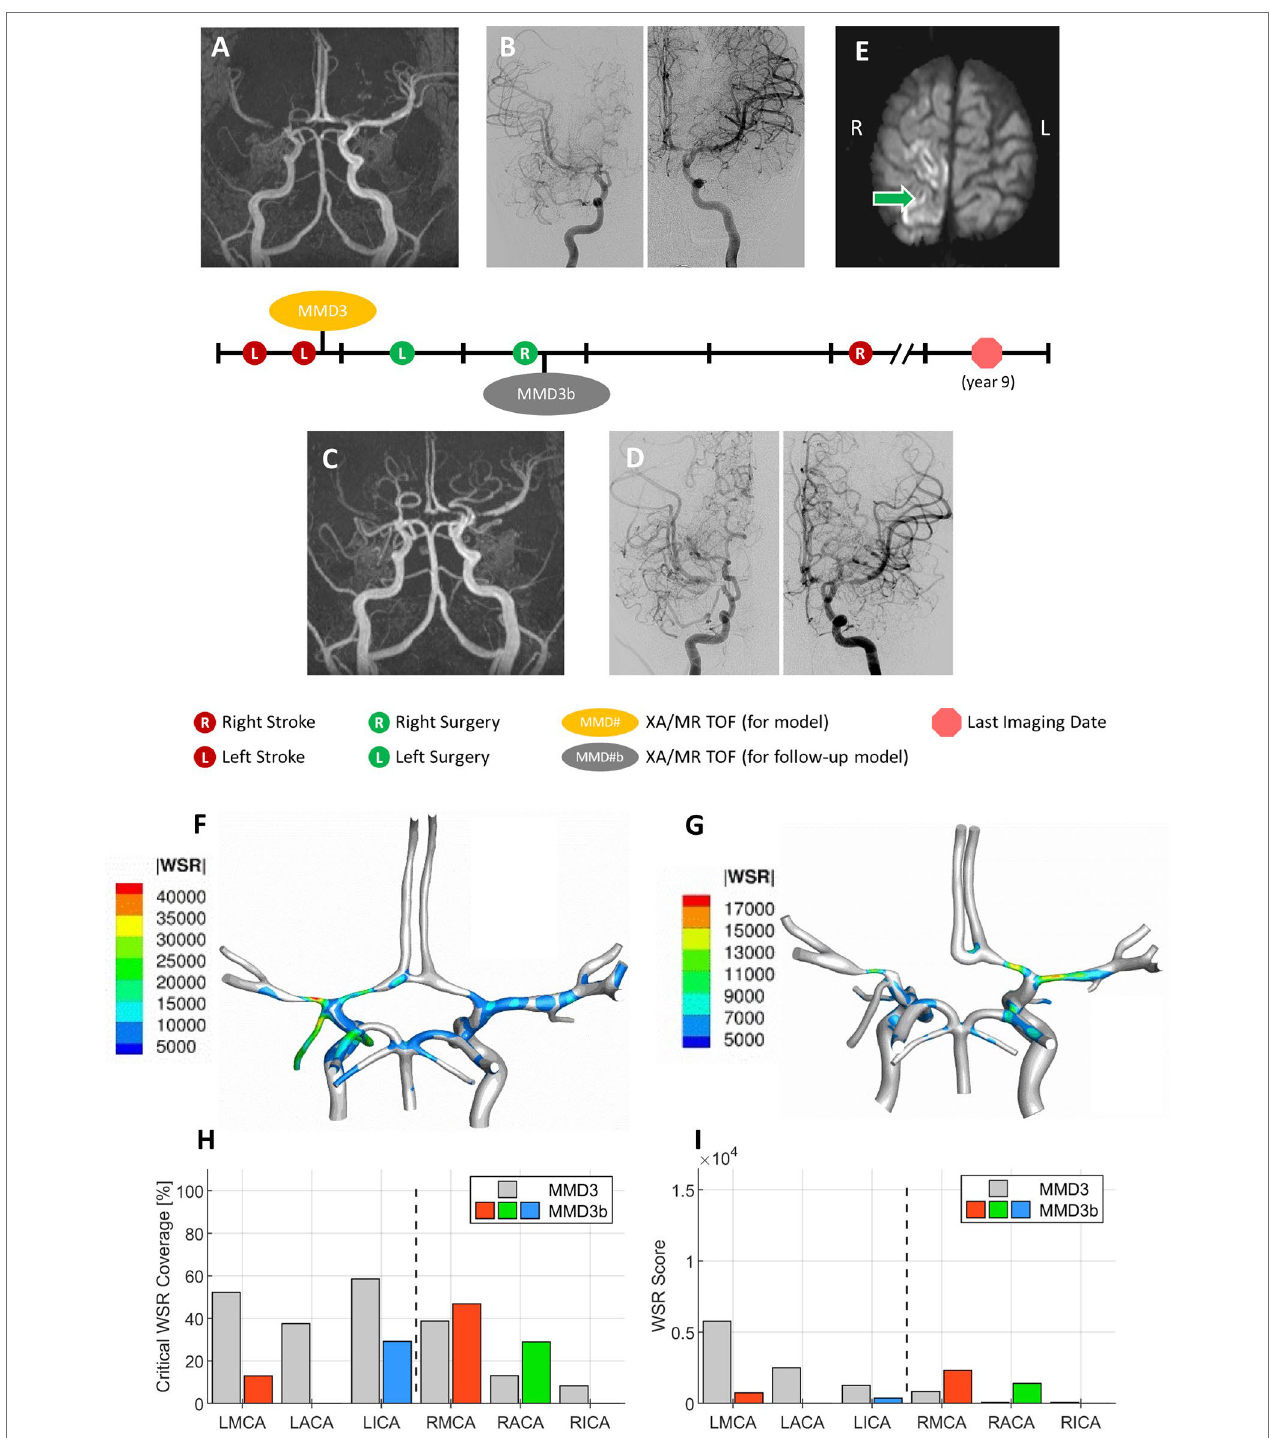
FIGURE 8 | A representative case. Patient presented with multiple transient ischemia attacks on the left side. Initial brain MR TOF (A) and XA (B) confirmed occlusion of left M1 and left A1, and mild to moderate narrowing of right A1 and right M1 segments. The patient underwent unilateral left dural inversion surgery. The follow-up MR TOF (C) and XA (D) imaging within 2 years from the initial diagnosis show evidence of moderate contralateral progression of disease and right dural inversion surgery. (E) In the follow-up transverse (axial) soft tissue MR image (SENSE sequence) at approximately 5 years from the initial diagnosis, evidence of right- sided stroke within perirolandic region involving right MCA territories. (F) WSR distribution pattern in the patient’s CoW model MMD3 created from post-operative images shown in A and B, and (G) WSR distribution pattern for CoW model MMD3b created from post-operative images shown in C and D. Plots reporting the critical WSR coverage (H) and WSR score (I) of each vessel for the second CoW model (MMD3b) with comparison to the results from MMD3 (gray